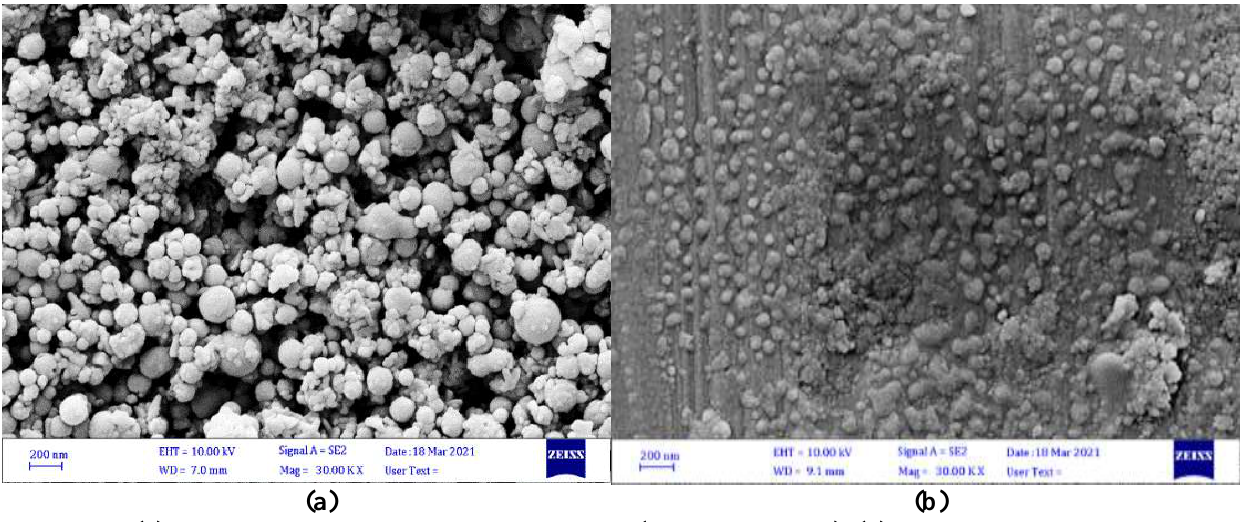
Figure 4: (a) Scanning electron micrographs of Al NPs (scale bar 200 nm). (b) Scanning electron micrographs of Al bulk (scale bar 200